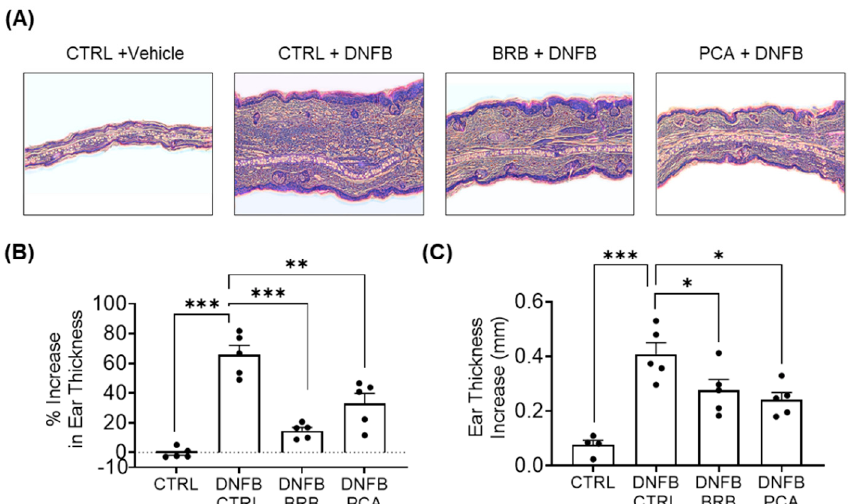
Figure 1. Auricular Inflammation is Attenuated in Mice Fed BRB and PCA Supplemented Diets During 2,4-dinitrofluorobenze (DNFB)-Induced contact hypersensitivity (CHS), with BRB displaying the strongest effects. ( A ) H&E stained cross sections of the challenged left ears taken from representative experimental mice at terminal sacrifice. ( B ) The percent increase in swelling of the left ears experimental mice 24 h following challenges 1 and 2. Measurements were determined by dividing the difference in ear size between the left challenged ear measurement and unchallenged right ear measurement, by the unchallenged right ear measurement. ( C ) Increase in ear thickness determined by taking the difference between individual left ear thickness and the unchallenged average right ear thickness of the respective group. * p -value ≤ 0.05; ** p -value < 0.01; *** p -value < 0.005 for comparisons between DNFB-challenged mice fed control diet and comparison groups using Student’s t test. Black circles represent individual mice. CTRL—control diet; BRB—black raspberry diet; PCA—protocatechuic acid diet.